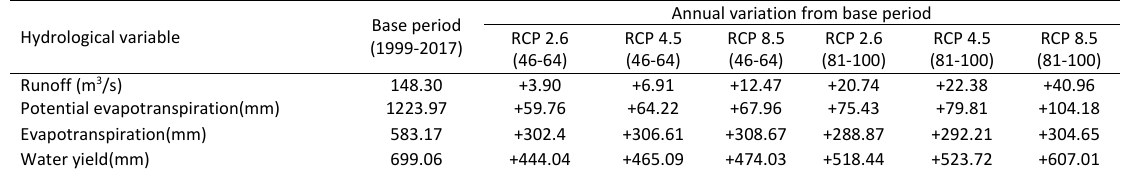
Table 7: Annual variation of hydrological parameters